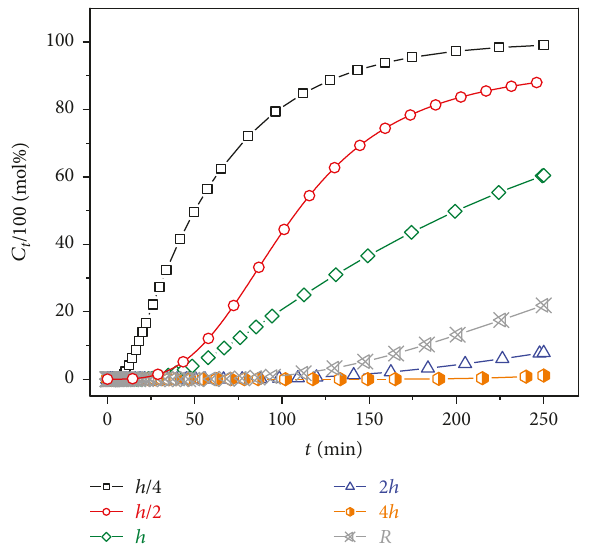
Figure 4: Simulation results of the in fl uence of sample geometry on the amount of sorbed acetone at θ = 20 ° C . Rectangular samples have the dimension: W × H × L: 2 × x × 50mm 3 , where x changes from h /4 to4 h and h is equal to 10mm. Cylindrical sample is 2 mm thick and has a radius of R = h mm.